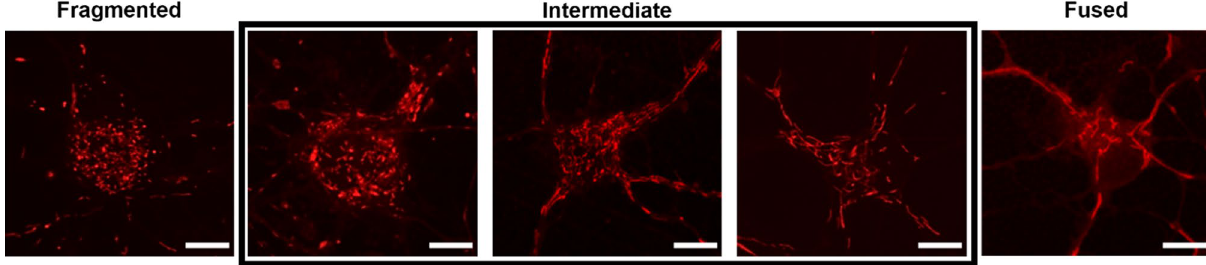
Figure 1. Mitochondrial morphology quantification reference scale. Cells were manually classified into one of 3 categories. Cells which exhibited more extreme fragmentation or hyper-fusion were counted to their closest equivalent. Neurons labeled with Mitotracker Red CMXRos. Scale bars indicate 10